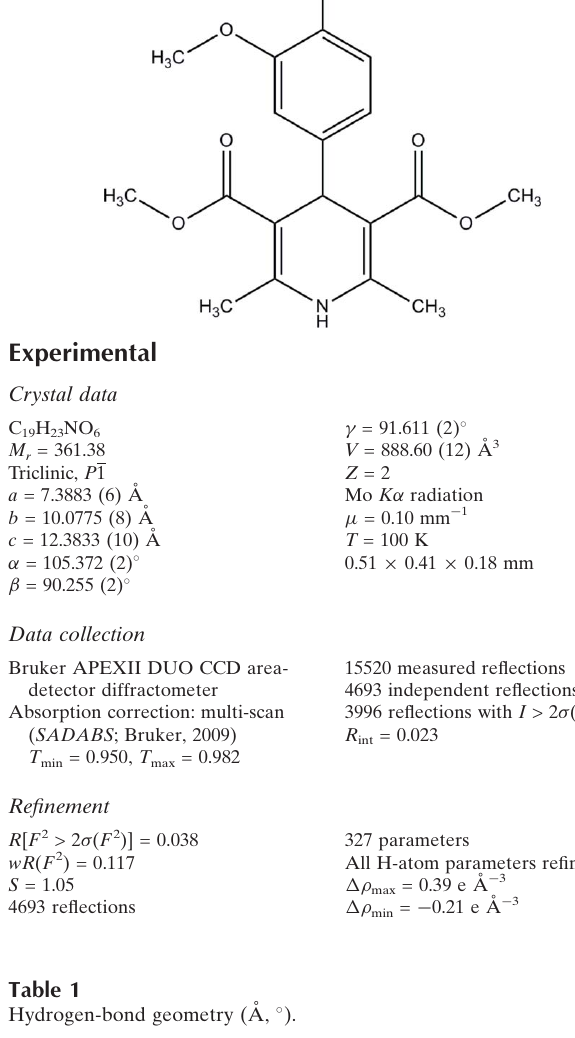
Hydrogen-bond geometry (A˚ , (cid:2)